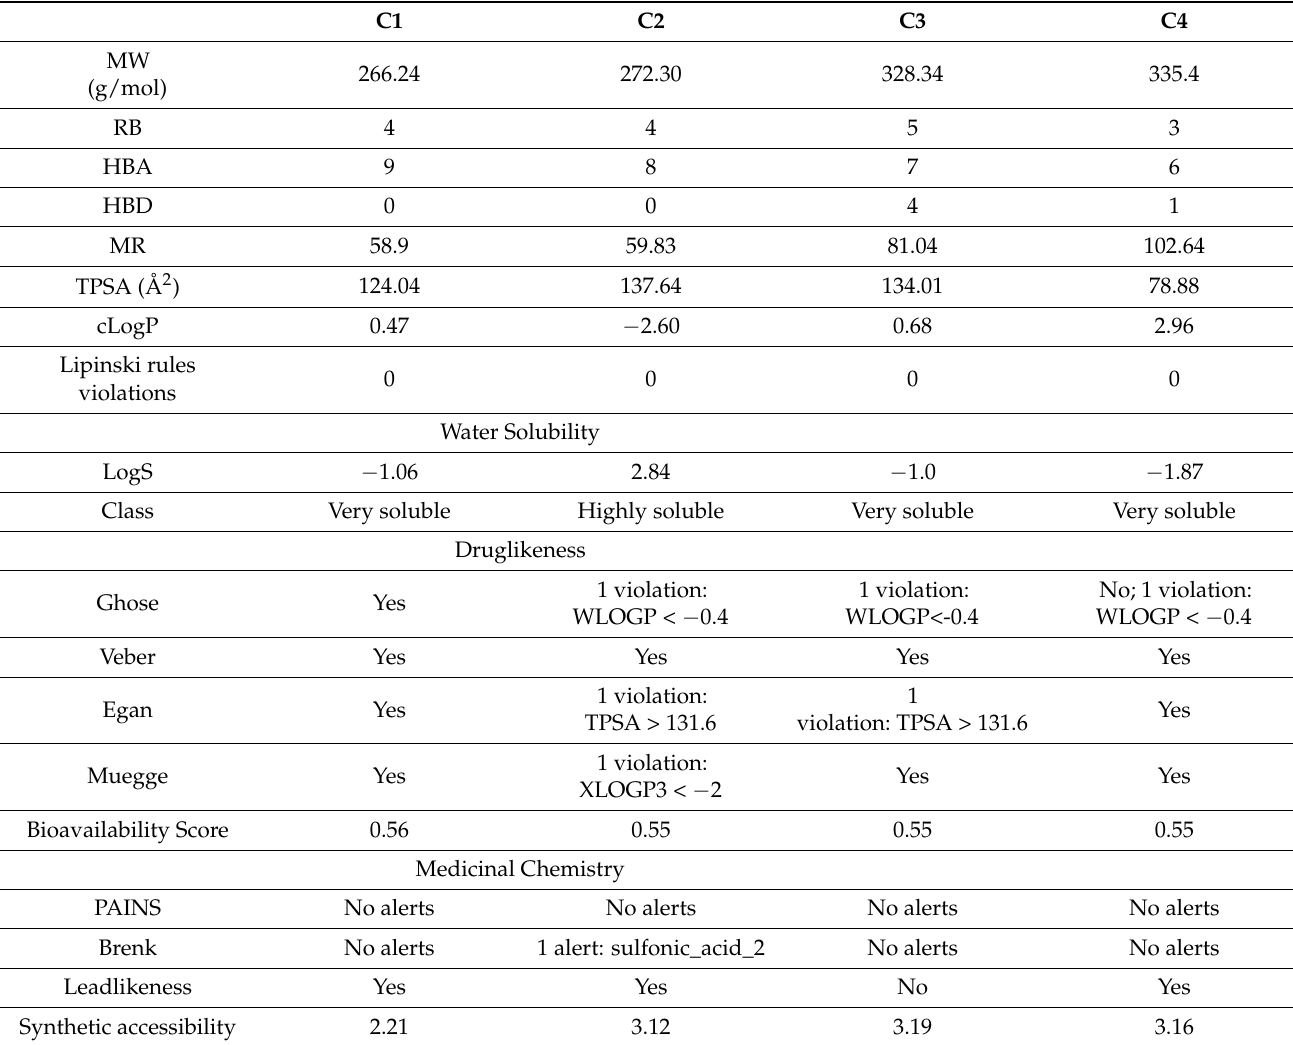
Table 4. Physicochemical properties of potential SaSK